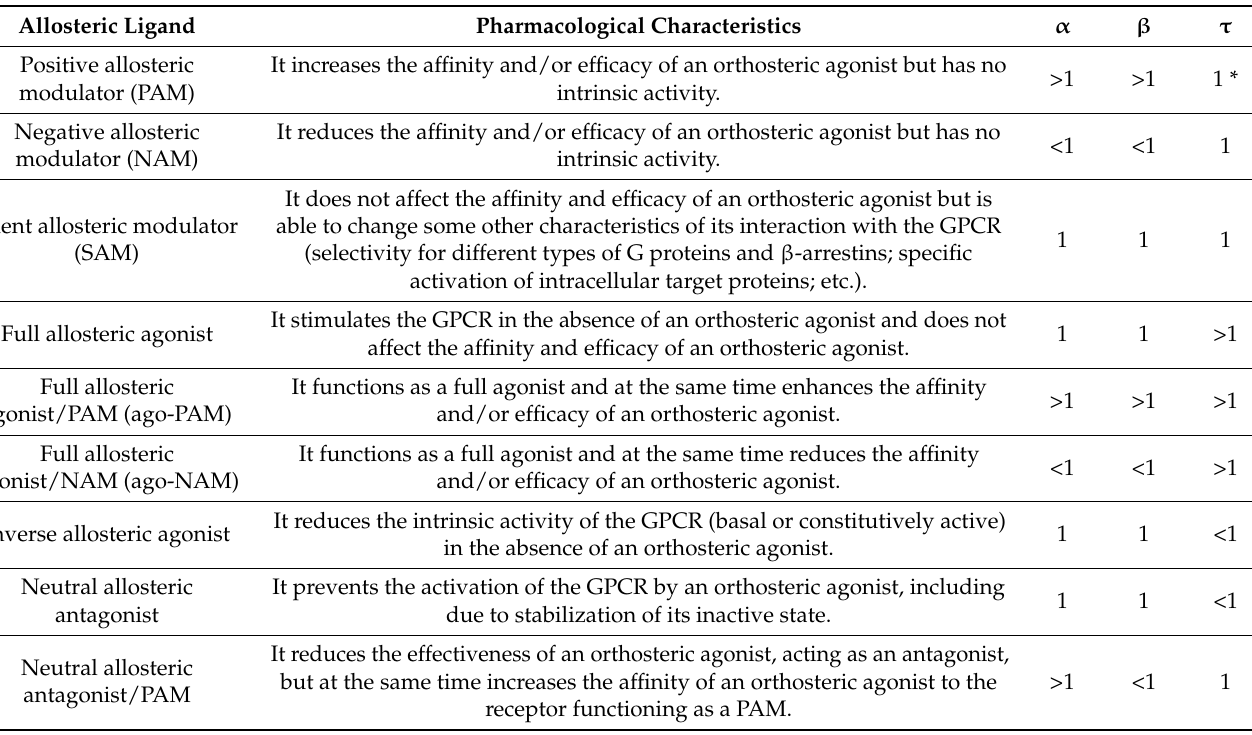
Table 1. The classification of allosteric regulators of